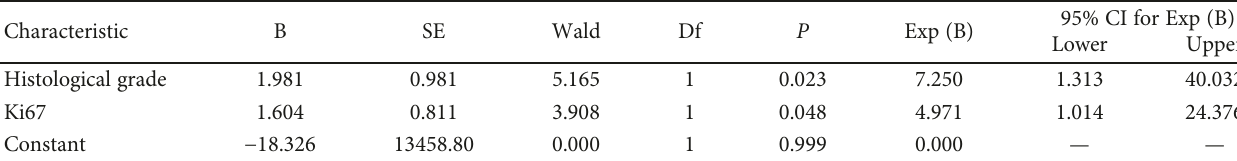
Table 2: Multivariate analysis of factors associated with